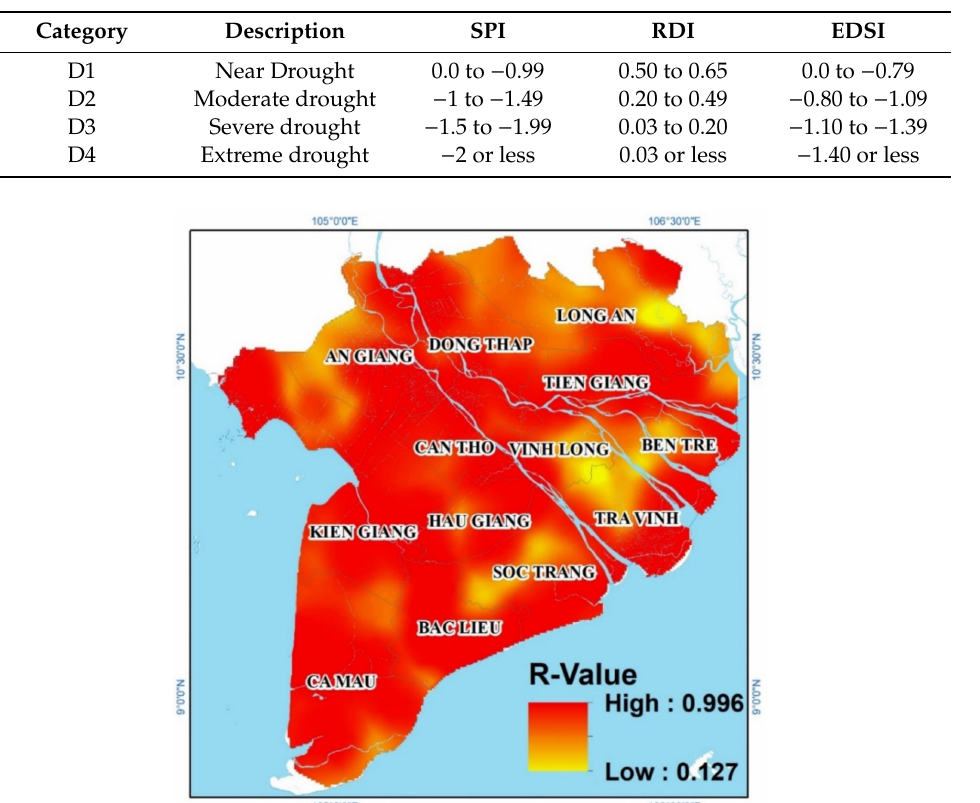
Figure 2. The spatiotemporal correlation between EDSI and DSI in the MRD during the time period of analysis using the geographically weighted regression (GWR).